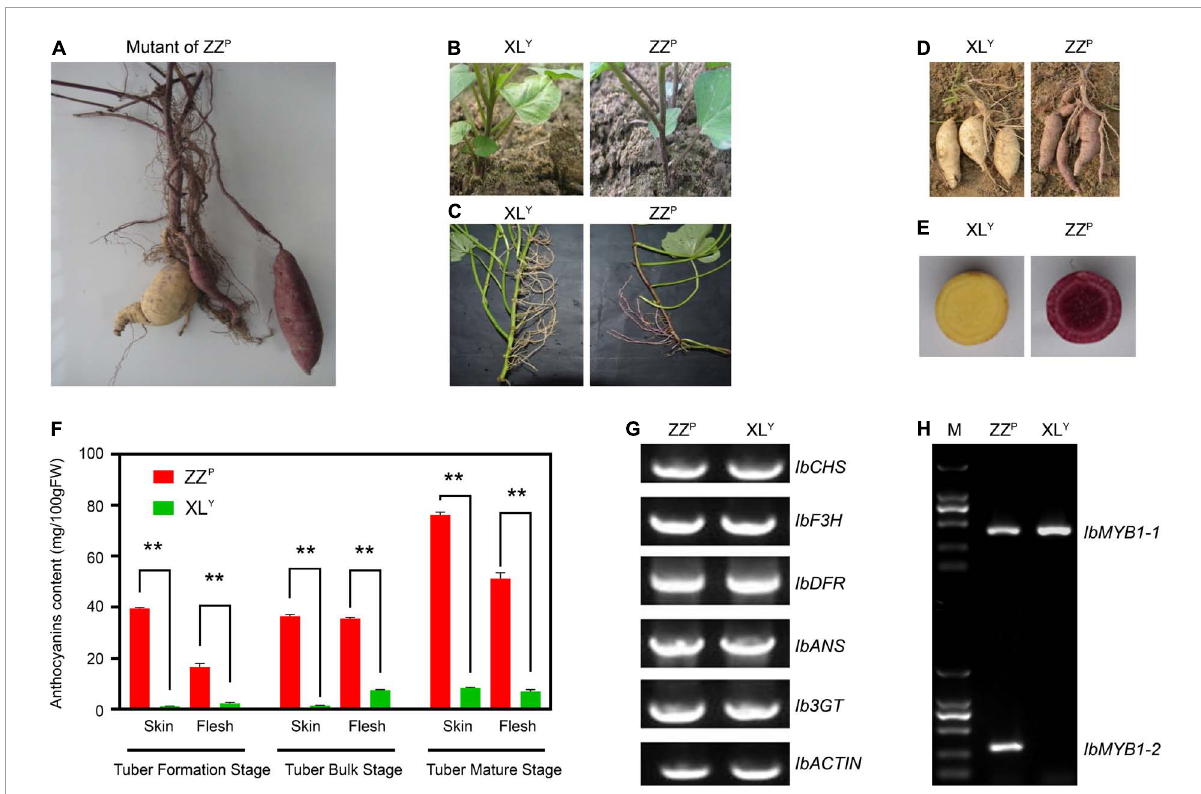
FIGURE1 Phenotype and genotype of the Zhezi.1 (ZZ P ) and Xinli (XL Y ) mutant. (A) First appearance of ZZ P mutant. (B) Plants of XL Y (Left) and ZZ P (Right) grown from tuberous roots. (C) Stems, (D) tuberous roots, and (E) cross-section of tuberous roots of XL Y (Left) and ZZ P (Right). (F) Anthocyanin content in tuberous roots of ZZ P and XL Y in different parts and stages. Error bars indicate the standard deviation from three biological replicates. Asterisks represent statistically significant differences (** P < 0.01), analyzed using Student’s t -test. (G) Genomic PCR for full CDS of structural genes involved in anthocyanin biosynthesis on ZZ P and XL Y . (H) Genotype of IbMYB1 in ZZ P and XL Y mutant. M, Marker of 2000.